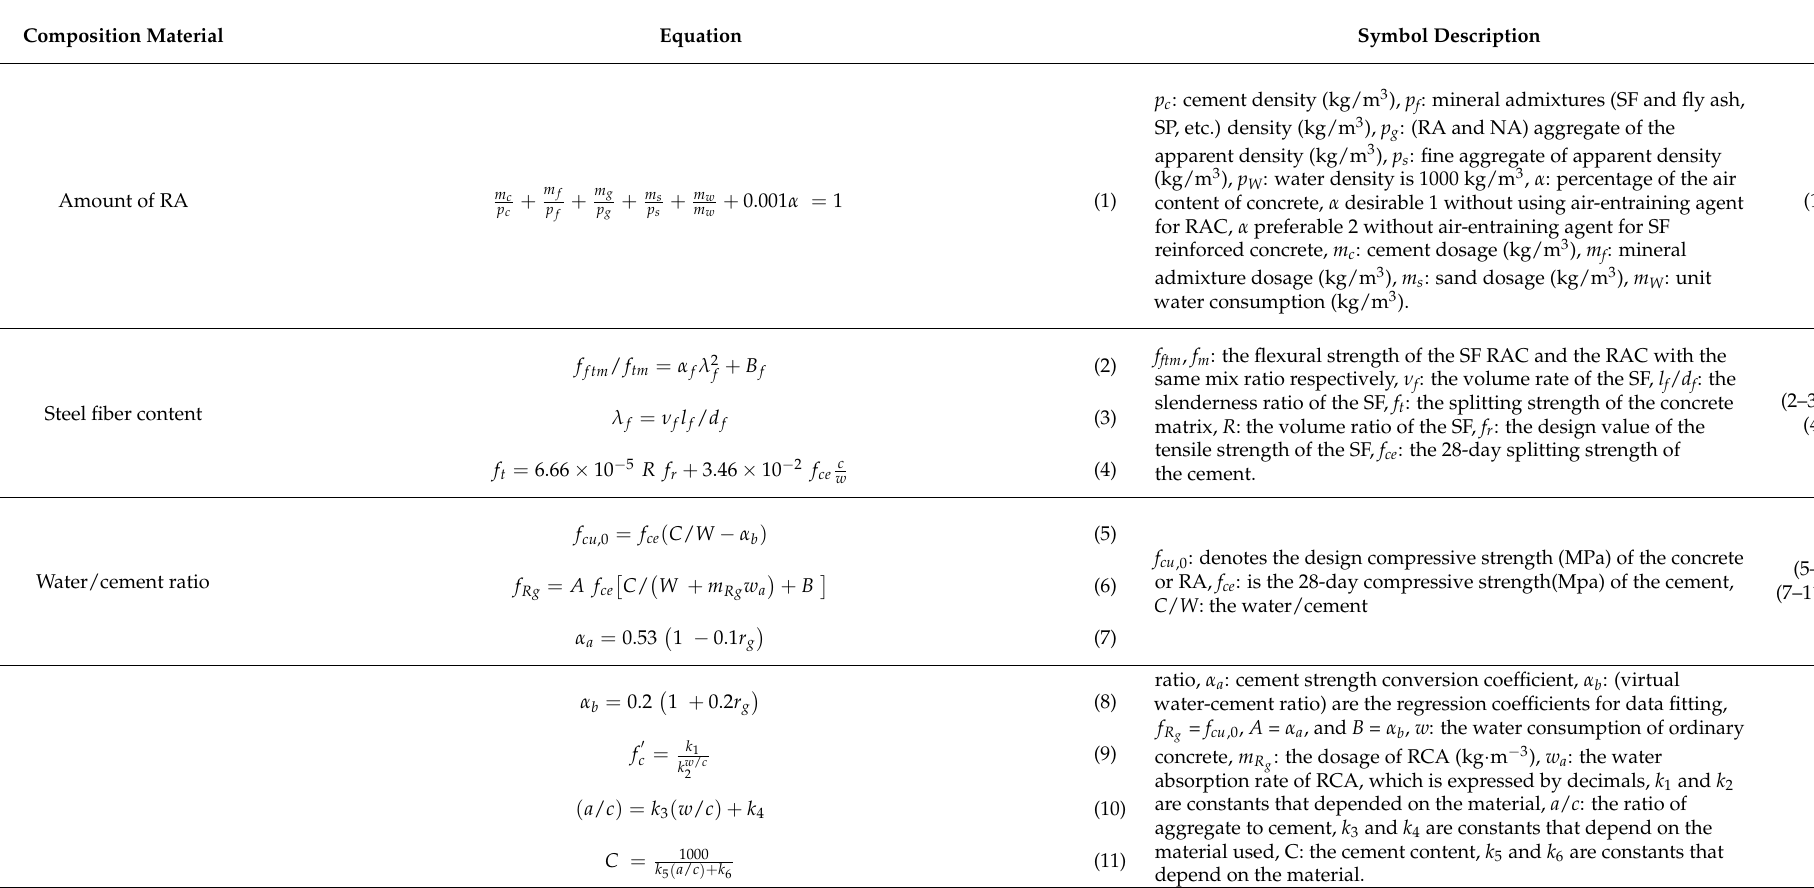
Table 6. Equation of mixture ratio of